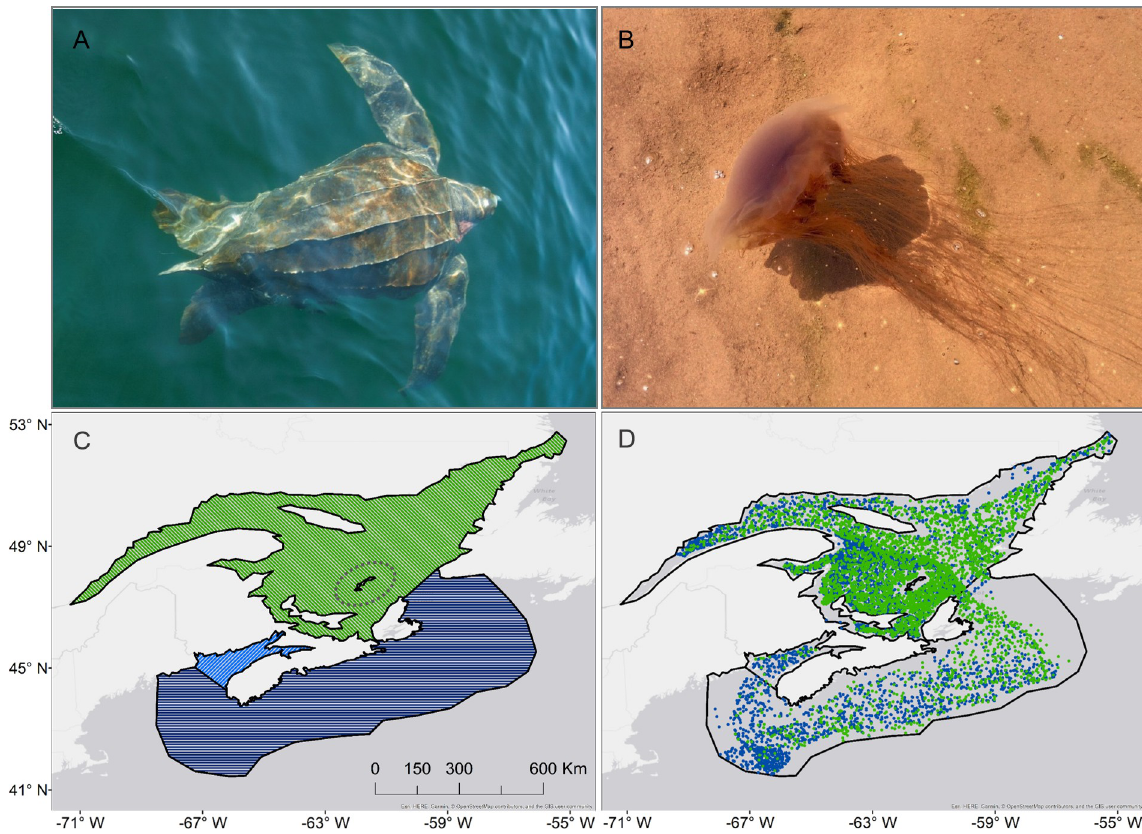
Fig 1. Study species and area in Atlantic Canada. A) Leatherback sea turtle (photo by Canadian Sea Turtle Network); B) lions mane jellyfish ( C . capillata ); C) biogeographical regions: Bay of Fundy in light blue, Scotian Shelf in dark blue, and the Gulf of St. Lawrence in green (Magdalen Islands circled within); regions are separated by black line; D) Department of Fisheries and Oceans trawl survey jellyfish presence (green dots) and absence (blue dots) 2006–2017.